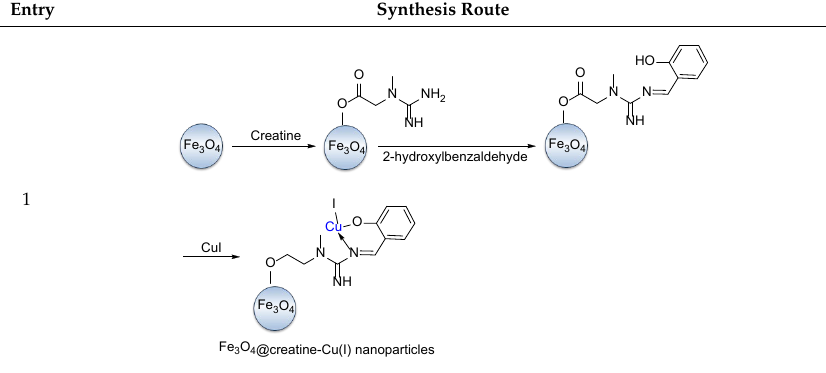
Table 2. The complete synthesis route of corresponding recoverable magnetic nanoparticles catalyst. Entry Synthesis Route